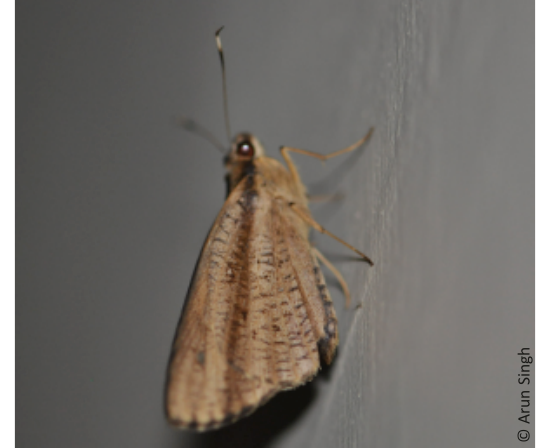
Image 4. Veined Palmer Hidari bhawani (underside;